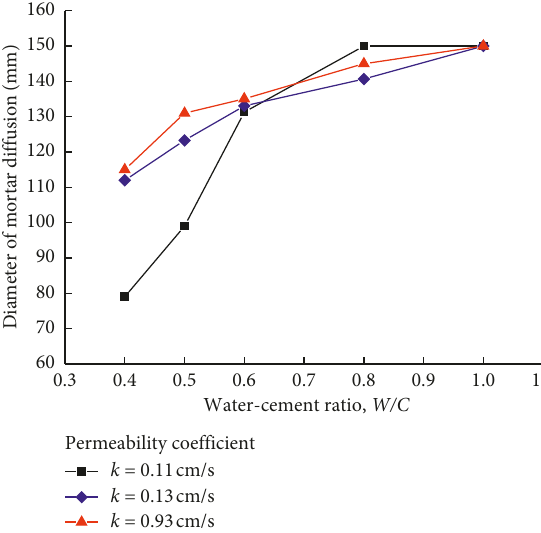
Figure 7: Characteristics of slurry diffusion ( P � 0.3 MPa).